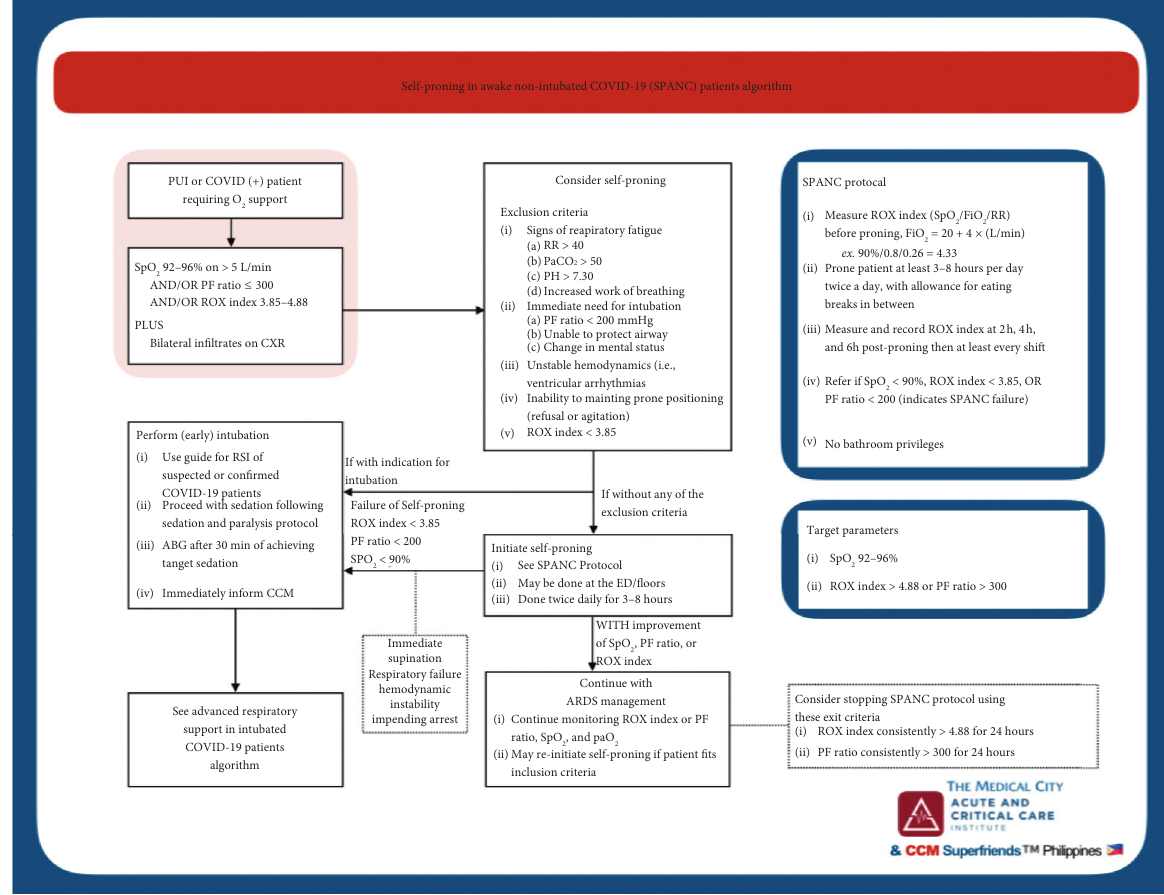
Figure 1: Self-Proning in Awake Nonintubated COVID-19 (SPANC) patients